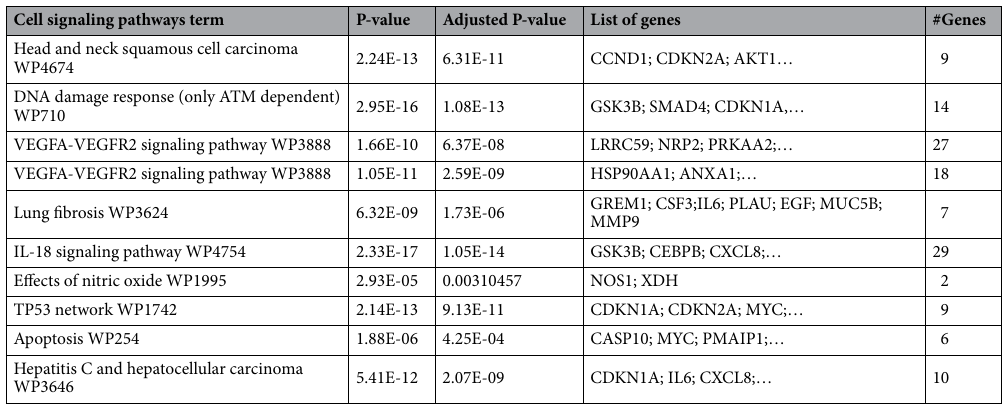
Table 8. The top cell signaling pathways’ names for the 10 GEO datasets. The first column is the name of the cell signaling pathway, the second column is the P-values, the third column is the adjusted P-value, the Genes column represents an example of the associated genes, and finally, the last column is the total number of associated genes.